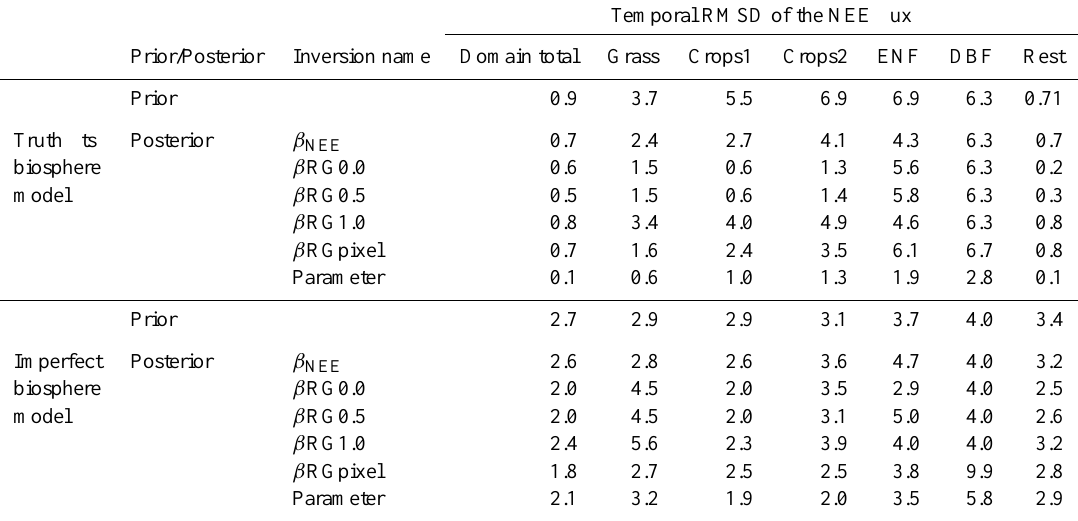
Table 3. The performance of the six inverse methods expressed as the RMSD of the optimized NEE time series compared to the truth, for the total domain and for each separated land use class [µmolm − 2 s − 1 ]. The upper part of the table shows the results of the control inversions, the lower part shows the results of the inversions where the truth is generated with a different biosphere model than the priors.